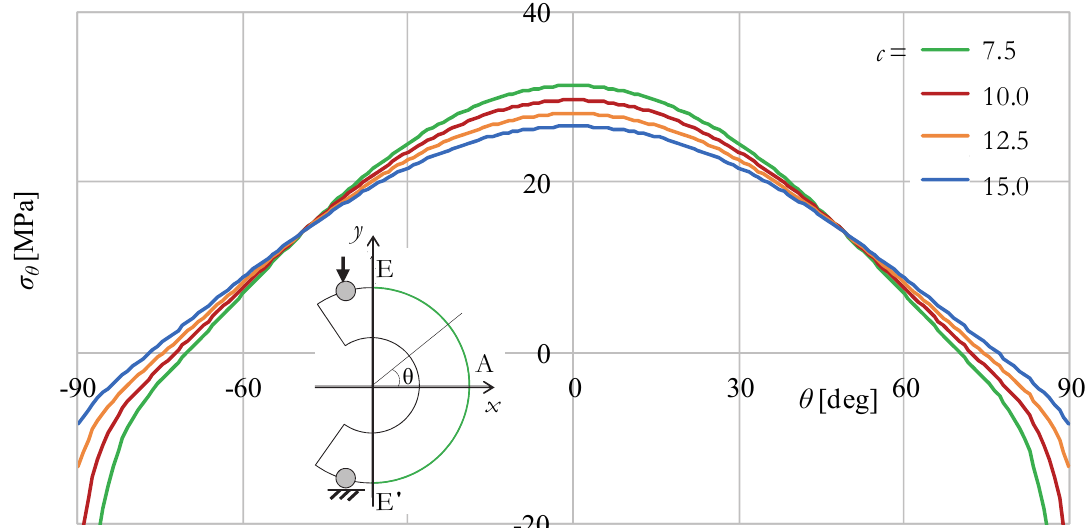
Figure 15: The polar distribution of the transverse normal stress along the outer perimeter of the CSR for various c -values (in mm).